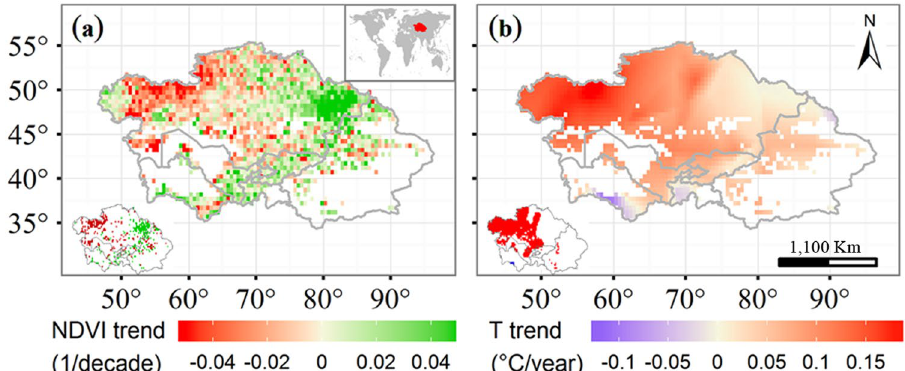
Figure 1. Spatial linear trends for the growing season Normalized Difference Vegetation Index (NDVI) ( a ) and temperature (T) ( b ) in Central Asia from 2000–2014. The insets indicate pixels that are statistically significant at p < 0.05. Maps were generated by using free software R (R Core Team (2015). R: A language and